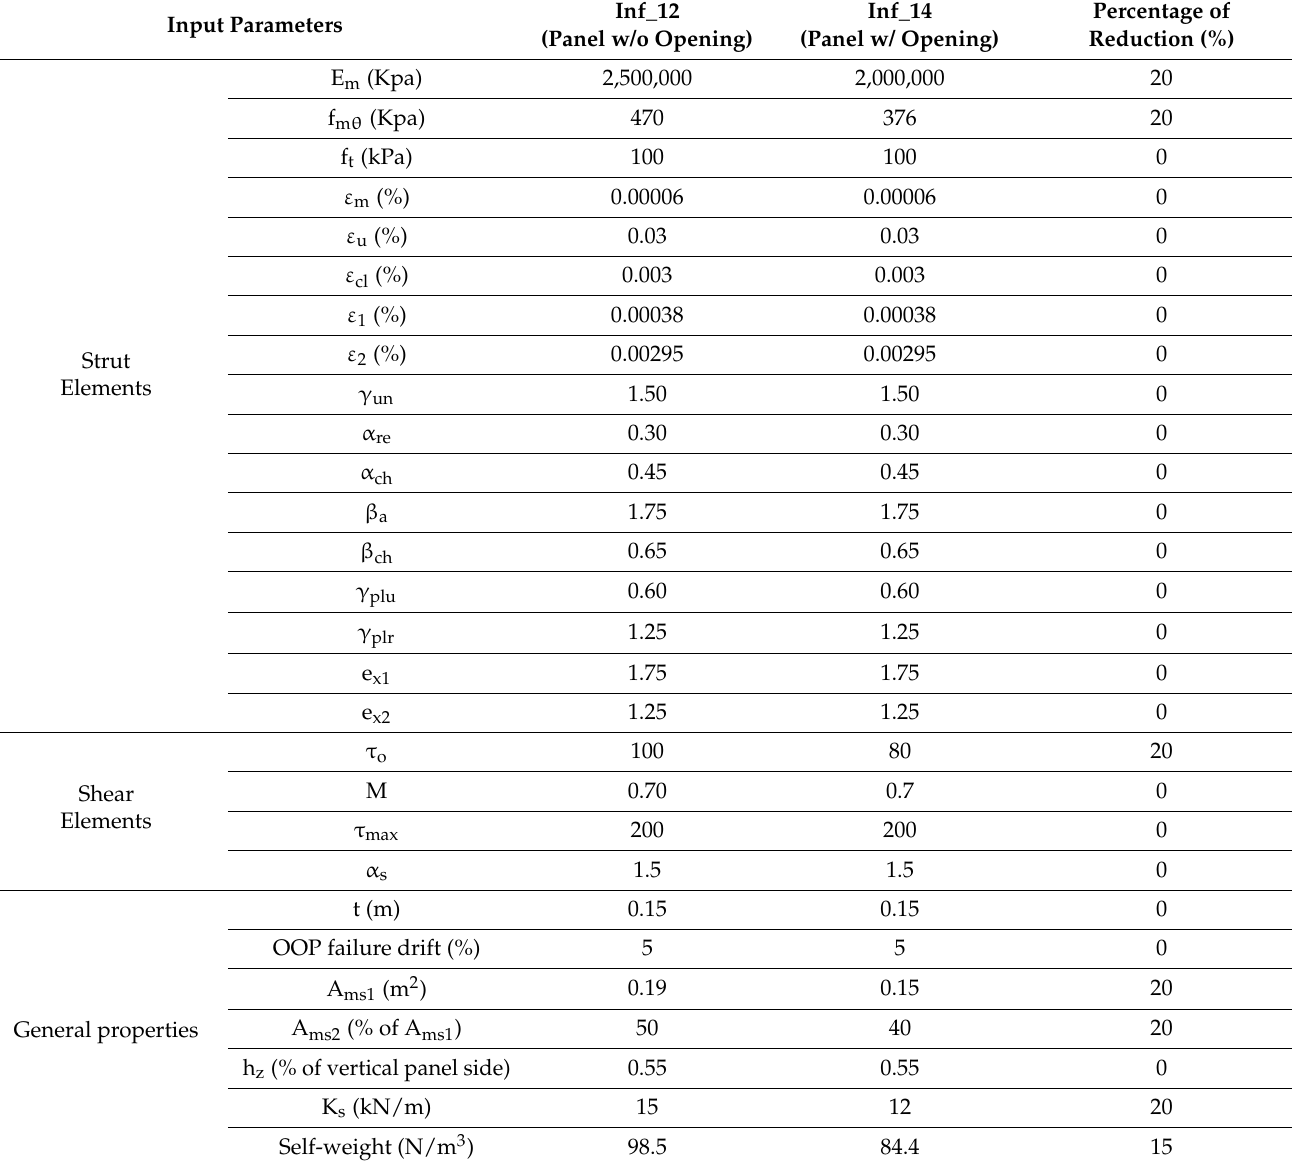
Table 1. Input material properties adopted for the masonry infill